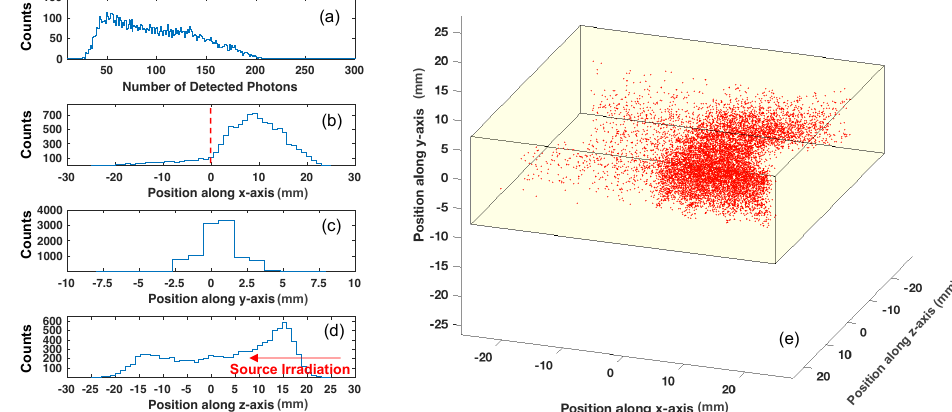
Figure 10. Energy spectrum from Cs-137 irradiation of the small scale prototype, calibrated to the number of detected photons is shown in ( a ). The reconstructed center of gravity positions of interaction along the x, y, and z axes are shown in ( b , c , d ), respectively. The red vertical dashed line in ( b ) indicates the edge of the tungsten block that was used to shield the x < 0 region of the scintillator. In ( e ), a three-dimensional plot of the calculated positions of interaction is